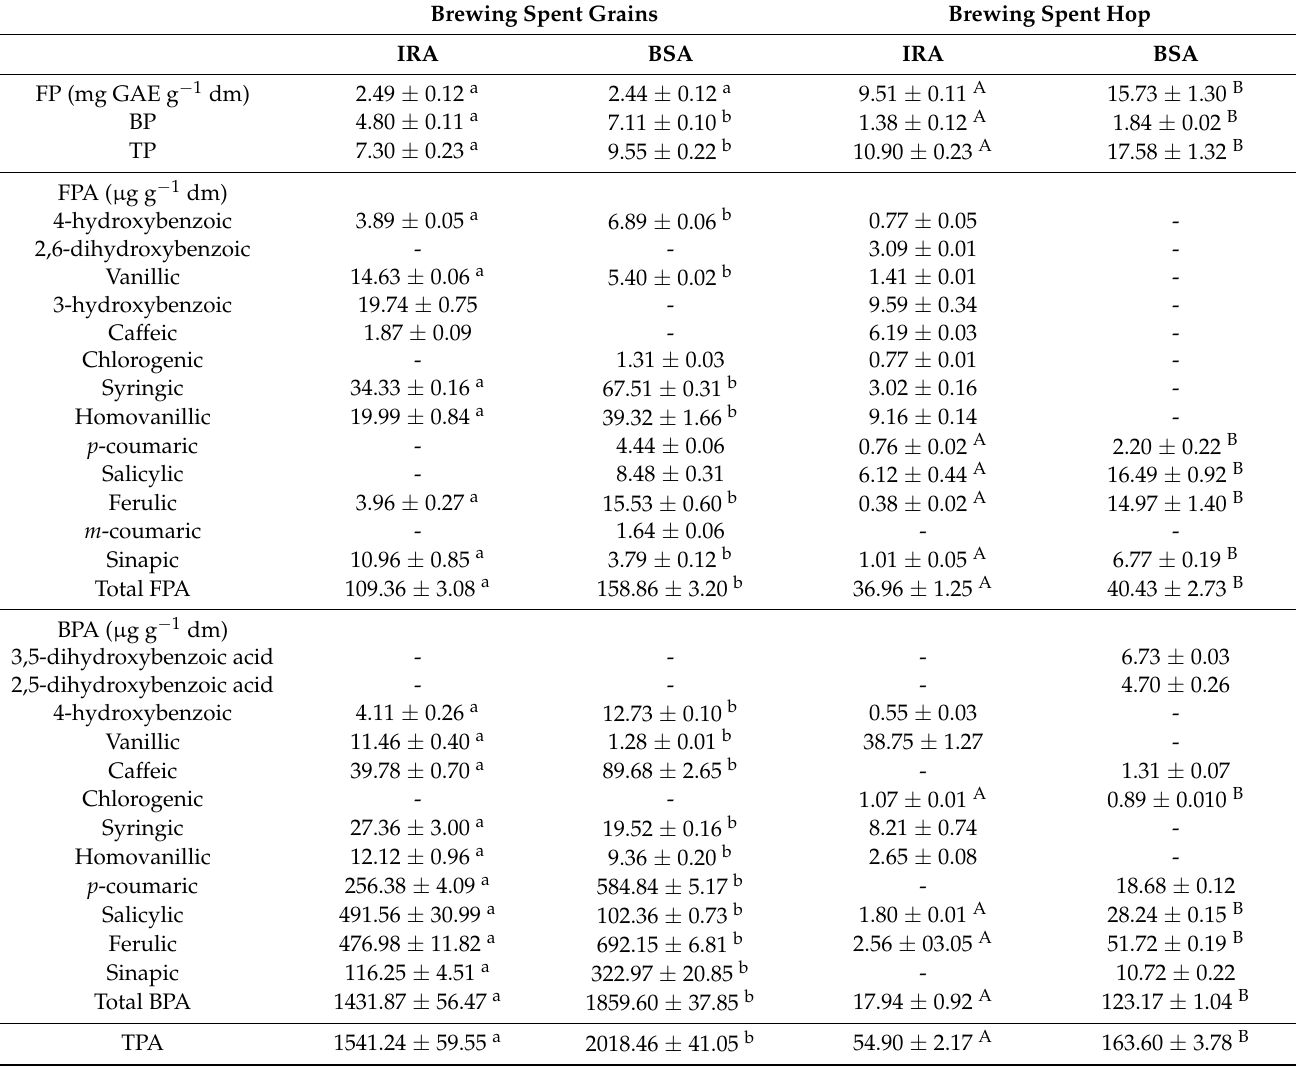
Table 3. Free and bound polyphenols content (mg GAE g − 1 dm) and phenolic acids profile ( µ g g − 1 dm) of spent grains and spent hop samples from the brewing of Imperial red and Belgian strong ale